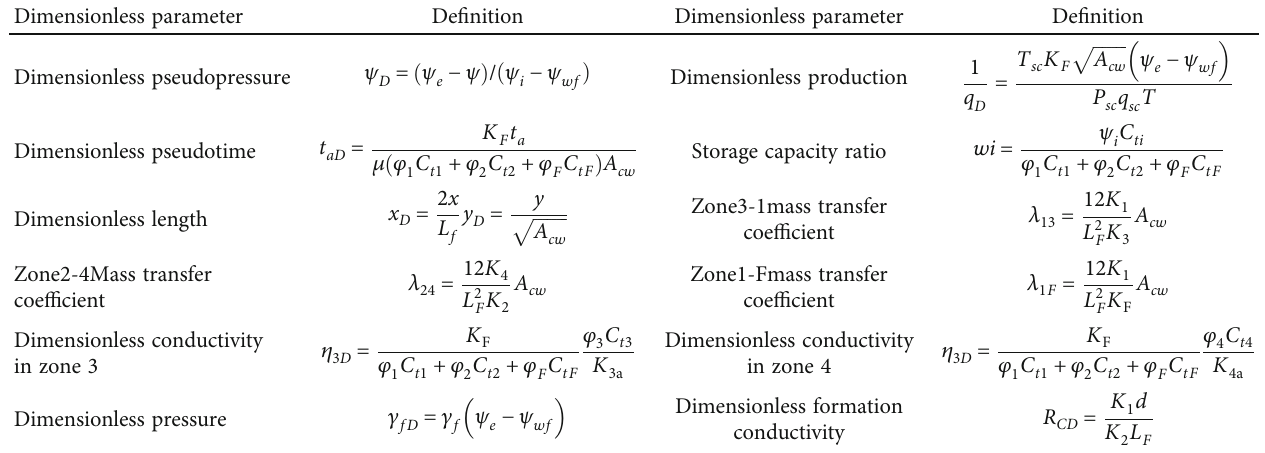
Table 1: Dimensionless parameters de fi